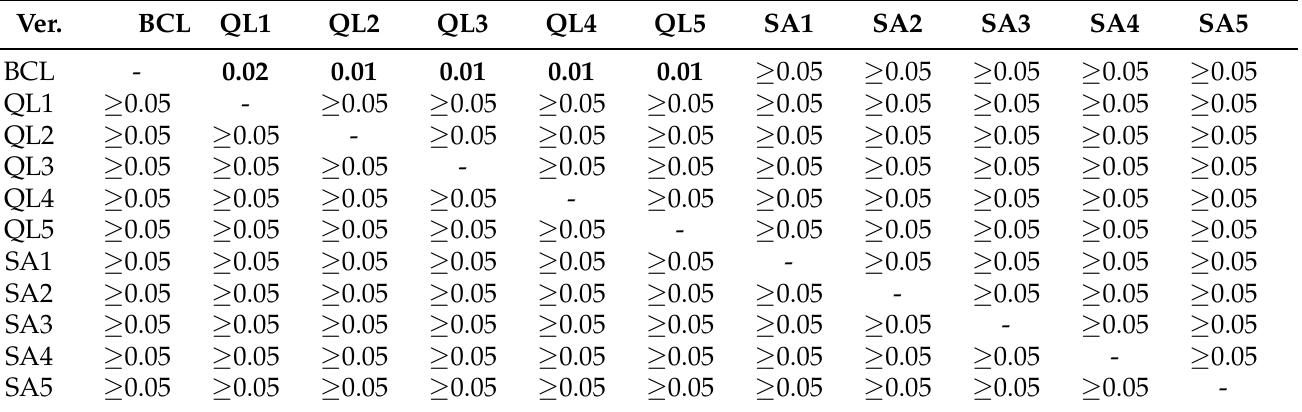
Table 18. The average Wilcoxon–Mann–Whitney test of